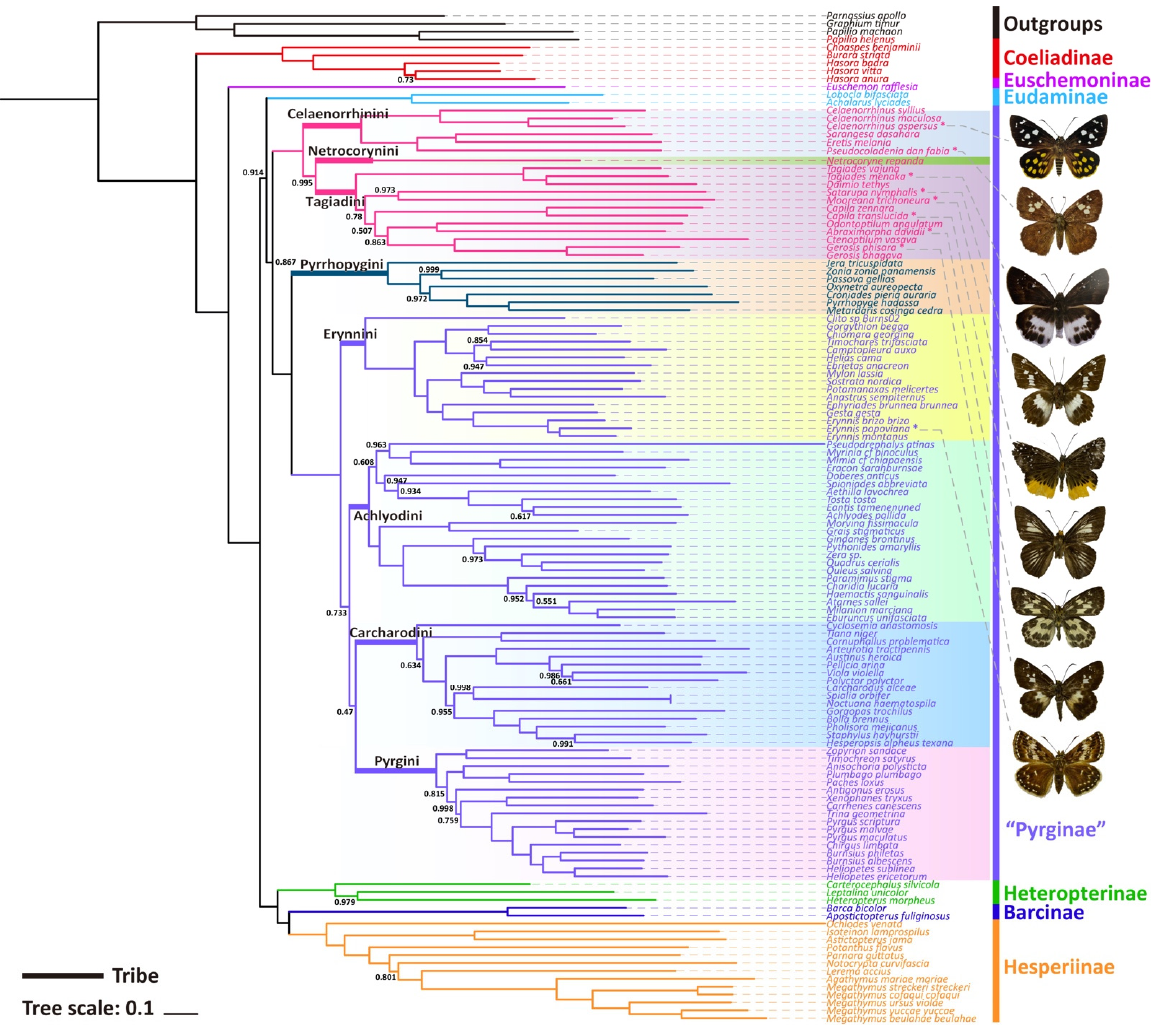
Figure 3. Phylogenetic tree produced by Mrbayes of PRT dataset. The bootstrap support (BS) values of 1 are hidden. of 1 are